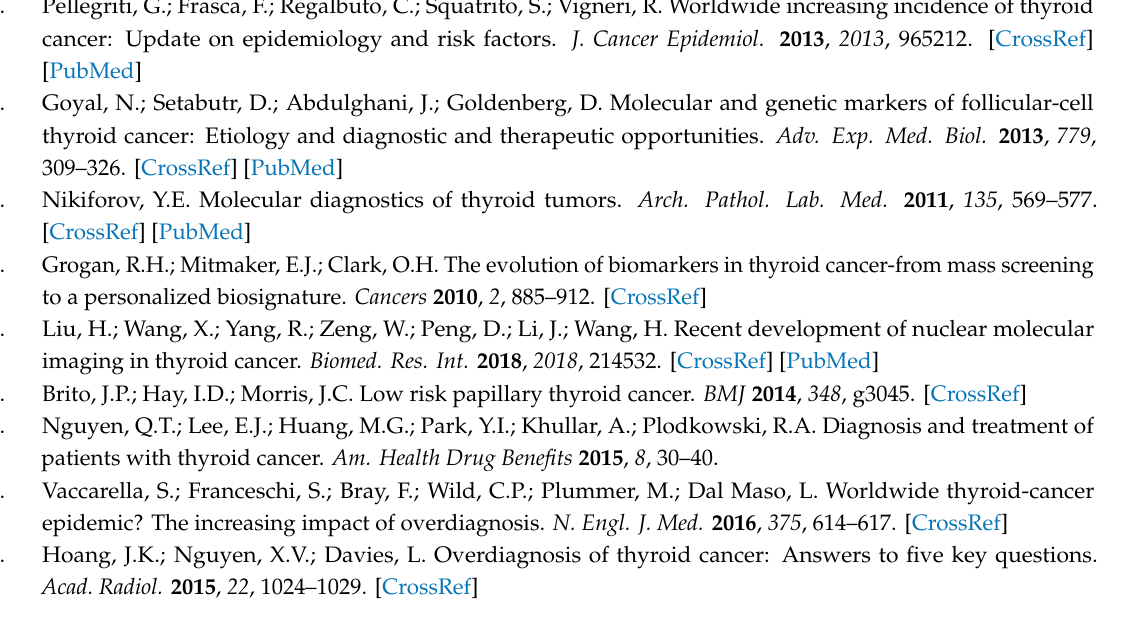
Figure S1: Pre- and post-contrast T2-weighted MR images of TPC-1 tumor grafted orthotopically at the neck level in athymic nude mice and injected with USPIO-P1. The images were acquired in axial and sagittal position at the head and neck level. Tu: tumor; Mu: muscle; Th: trachea; SC: spinal cord; Br: